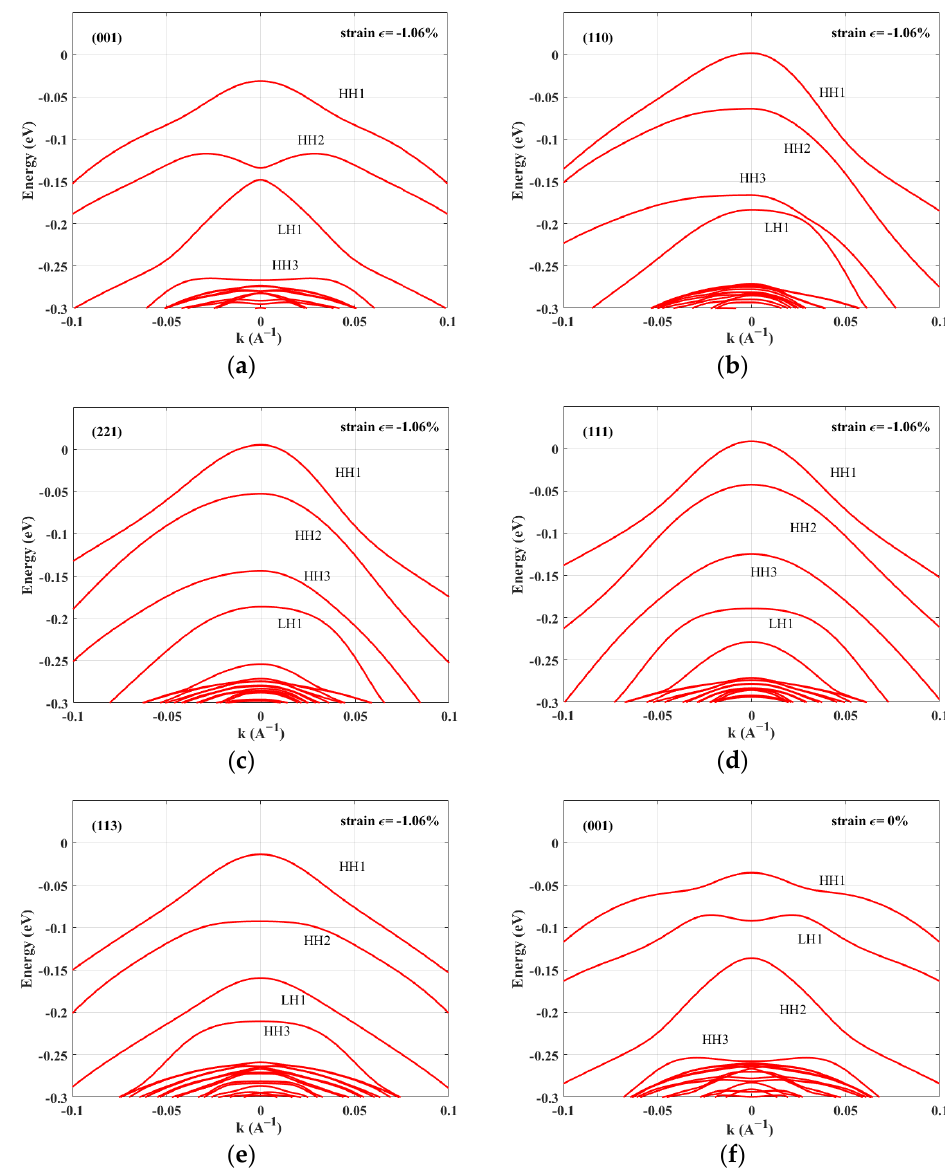
Figure 3. Valence band dispersions for a 1.06% compressive strained InGaAs QW with (a) (001), (b) (110), (c) (221), (d) (111), and (e) (113) orientations, and (f) for an unstrained InGaAs QW with (001) orientation.